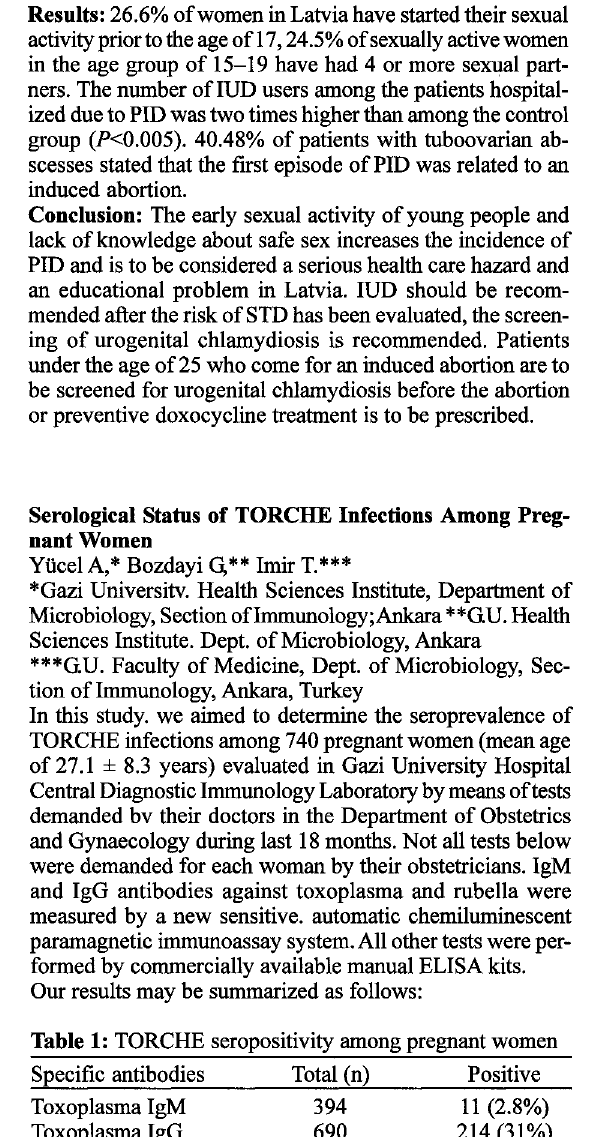
Table 2: IgG and IgM results for rubella, toxoplasma and CMV